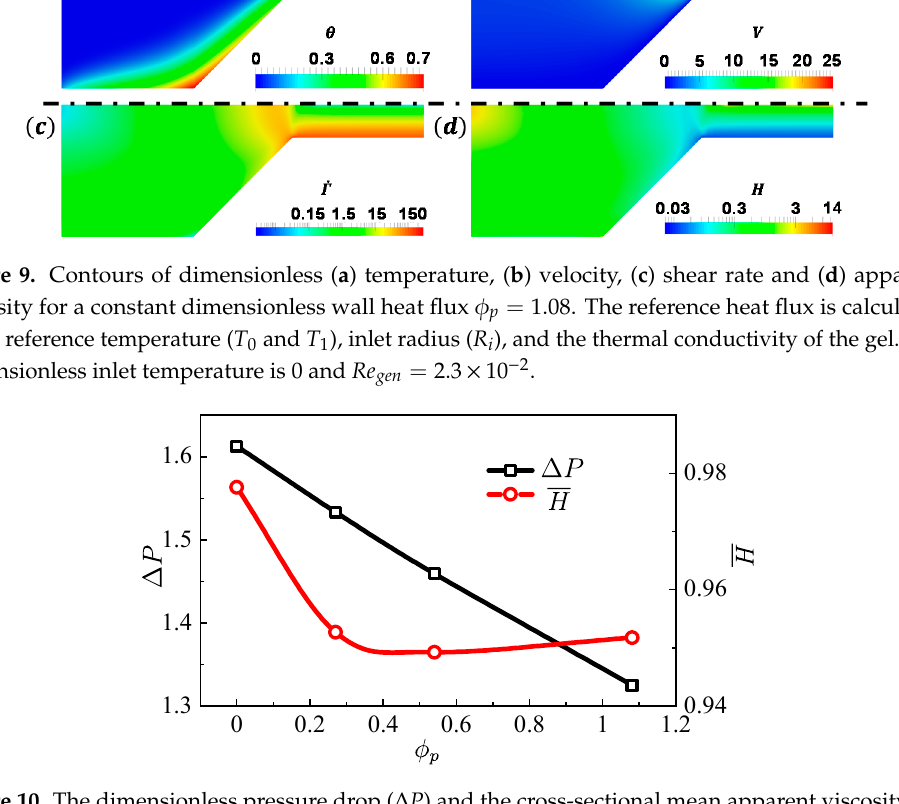
Figure 10. The dimensionless pressure drop ( ∆ P ) and the cross-sectional mean apparent viscosity ( H ) for di ff erent values of the wall heat flux. The pressure drop and the outlet mean apparent viscosity when θ w = 1 and Re gen = 2.3 × 10 − 2 are used as the reference parameters.